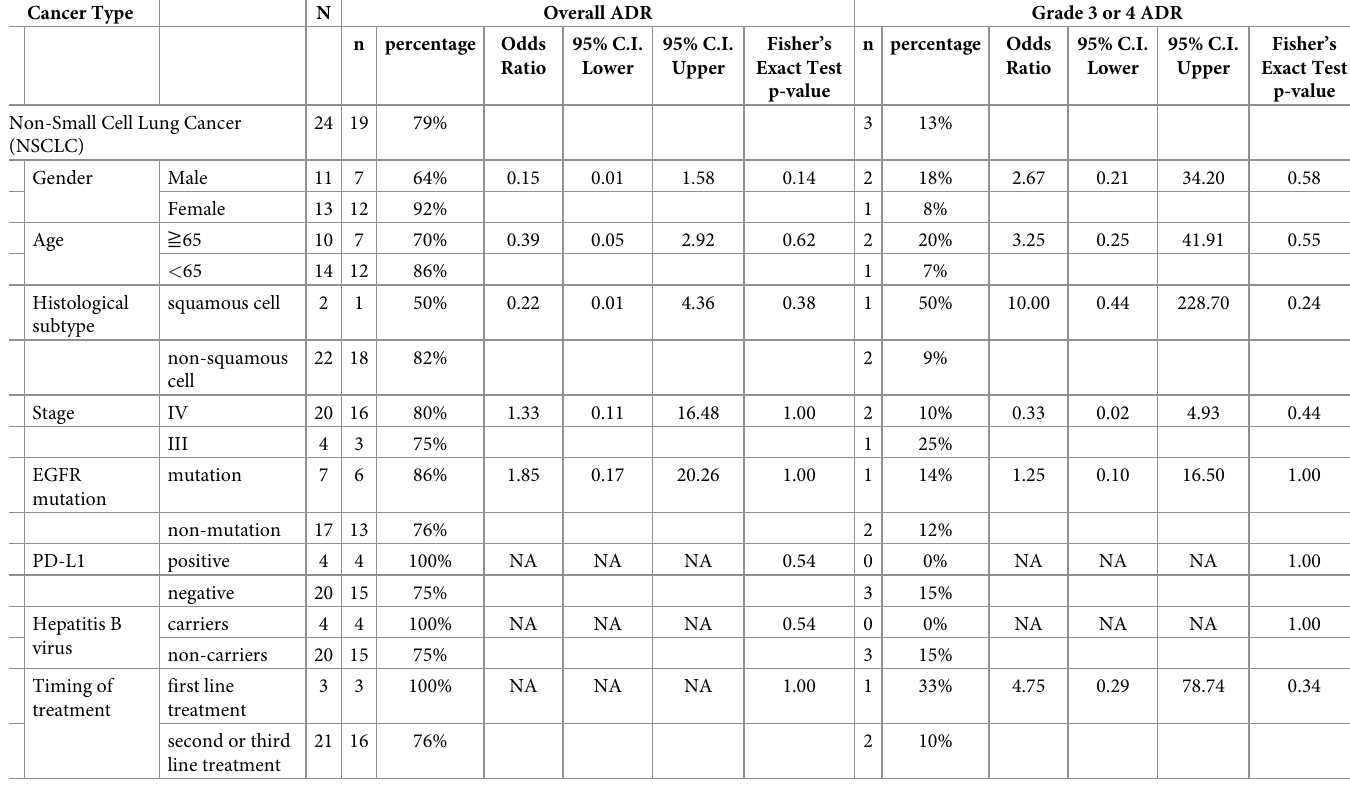
Table 6. Safety of immuno-therapies for NSCLC treatment (n =